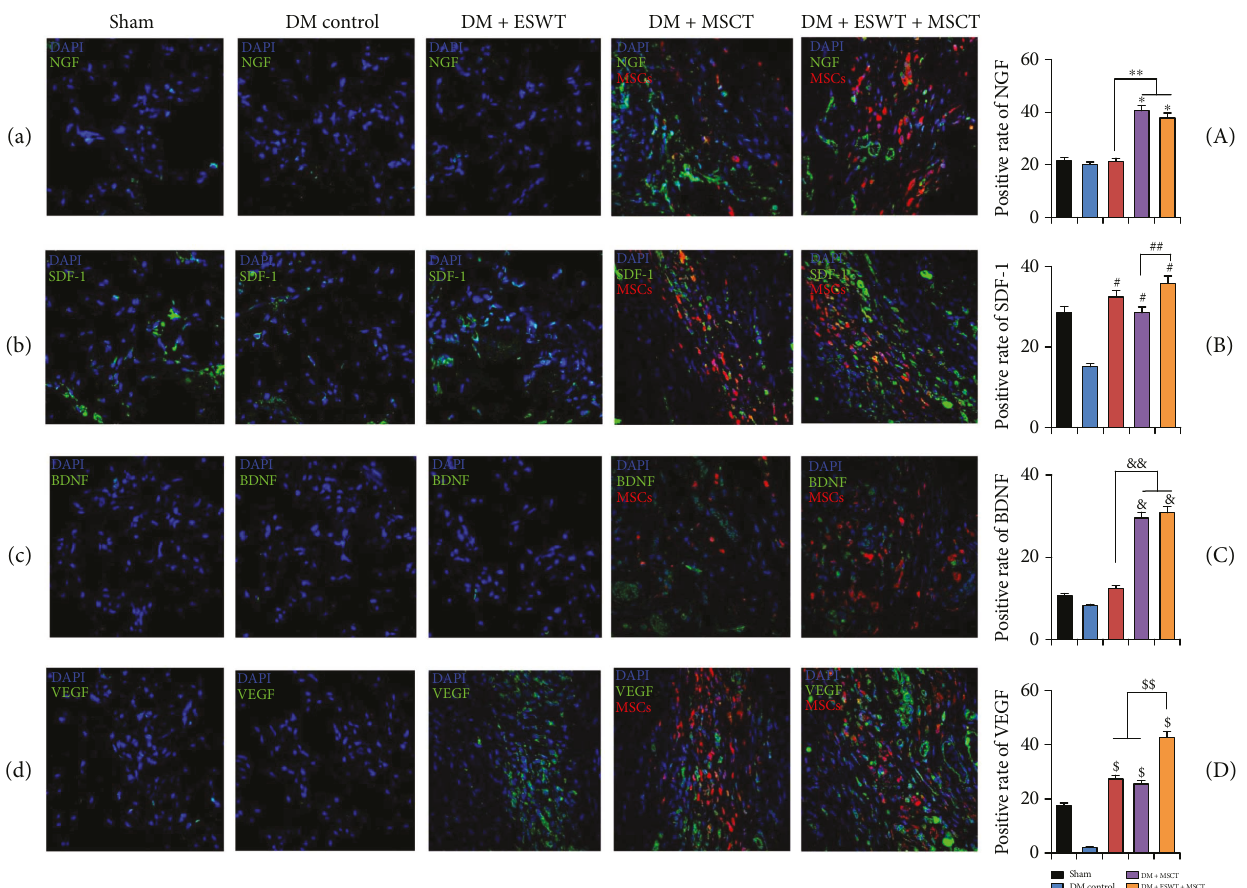
Figure 3: ESWT+ MSCT promoted proliferation and migration in vivo. (a) Representative images of NGF stain for each group. Original magni fi cation: × 200. (B) Positive rate of NGF for each group. Each bar shows the mean values (standard deviation). ∗ P < 0 01 compared with the DM control group, ∗∗ P < 0 01 . (b) Representative images of SDF-1 stain for each group. Original magni fi cation: × 200. (B) Positive rate of SDF-1 for each group. Each bar shows the mean values (standard deviation). # P < 0 01 compared with the DM control group, ## P < 0 05 . (b) Representative images of BDNF stain for each group. Original magni fi cation: × 200. (B) Positive rate of BDNF for each group. Each bar shows the mean values (standard deviation). & P < 0 01 compared with the DM control group, && P < 0 01 . (b) Representative images of VEGF stain for each group. Original magni fi cation: × 200. (b) Positive rate of VEGF for each group. Each bar shows the mean values (standard deviation). $ P < 0 01 compared with the DM control group, $$ P < 0 05